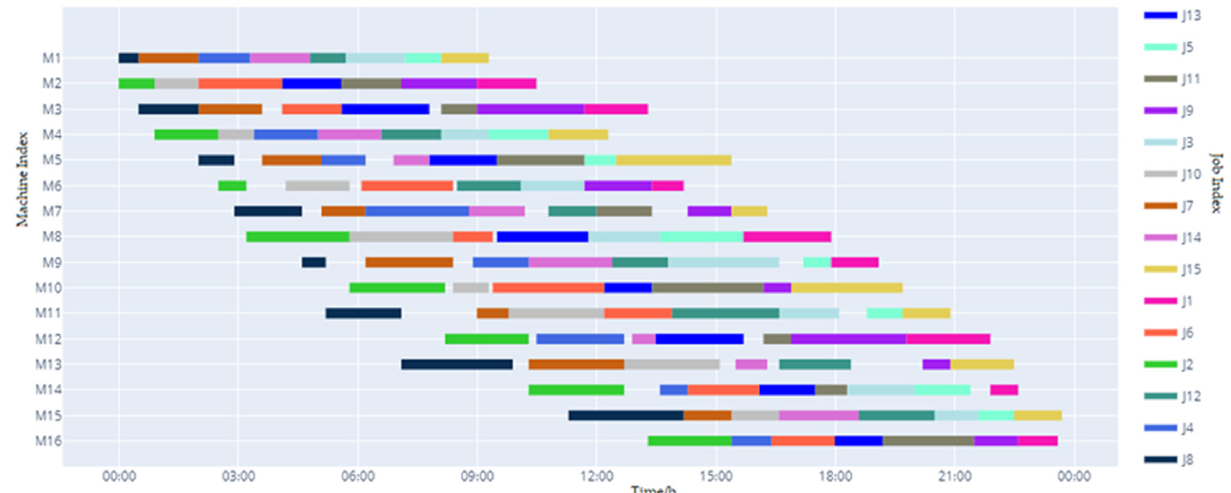
Figure 8. Gantt after the Right-Shift.